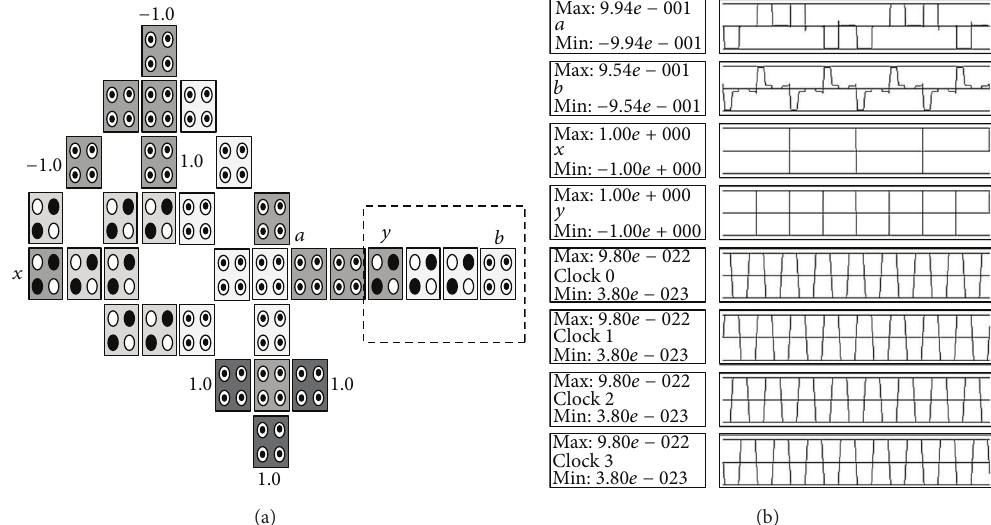
Figure 11: The proposed QCA for the CNOT gate: (a) the layout where the added cells to the basic building block are highlighted with dashed line, (b) the simulation